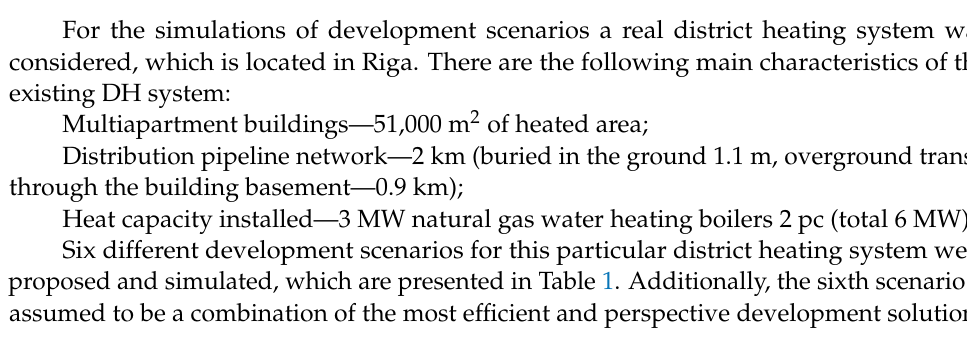
Table 1. Description of simulation scenarios.